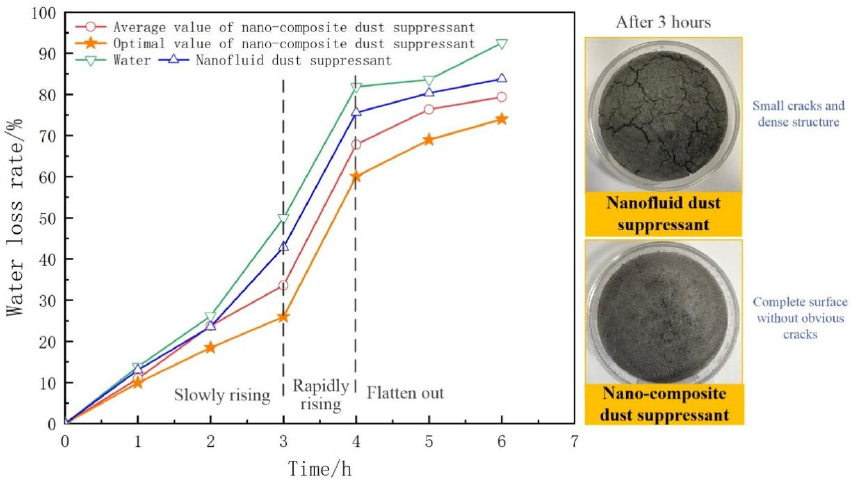
Figure 6. The results of water loss rate.